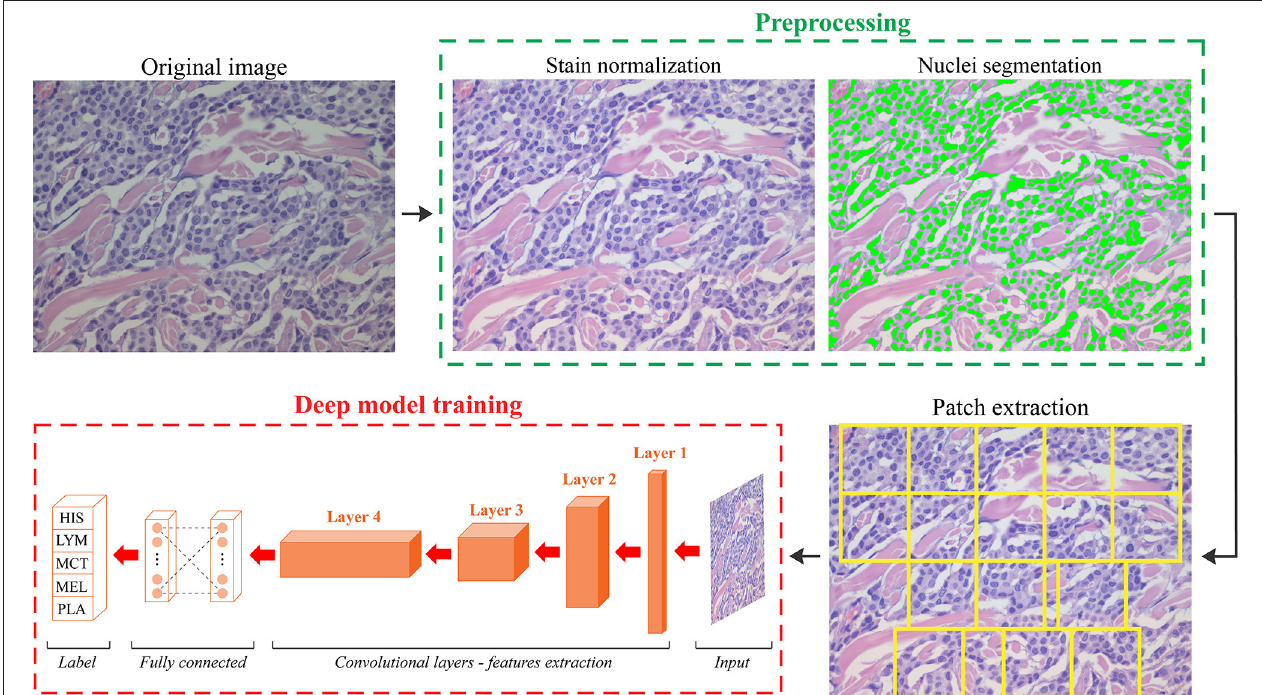
FIGURE 1 | Schematic representation of the ARCTA algorithm. Starting from the original RGB image, a pre-processing stage is employed to standardize the staining intensity and to detect cell nuclei. Patches are automatically extracted based on local nuclear density. Then, a deep learning model is exploited to perform canine round cell tumors (RCT) classification. HIS, histiocytoma; LYM, lymphoma; MCT, mast cell tumor; MEL, melanoma; PLA,